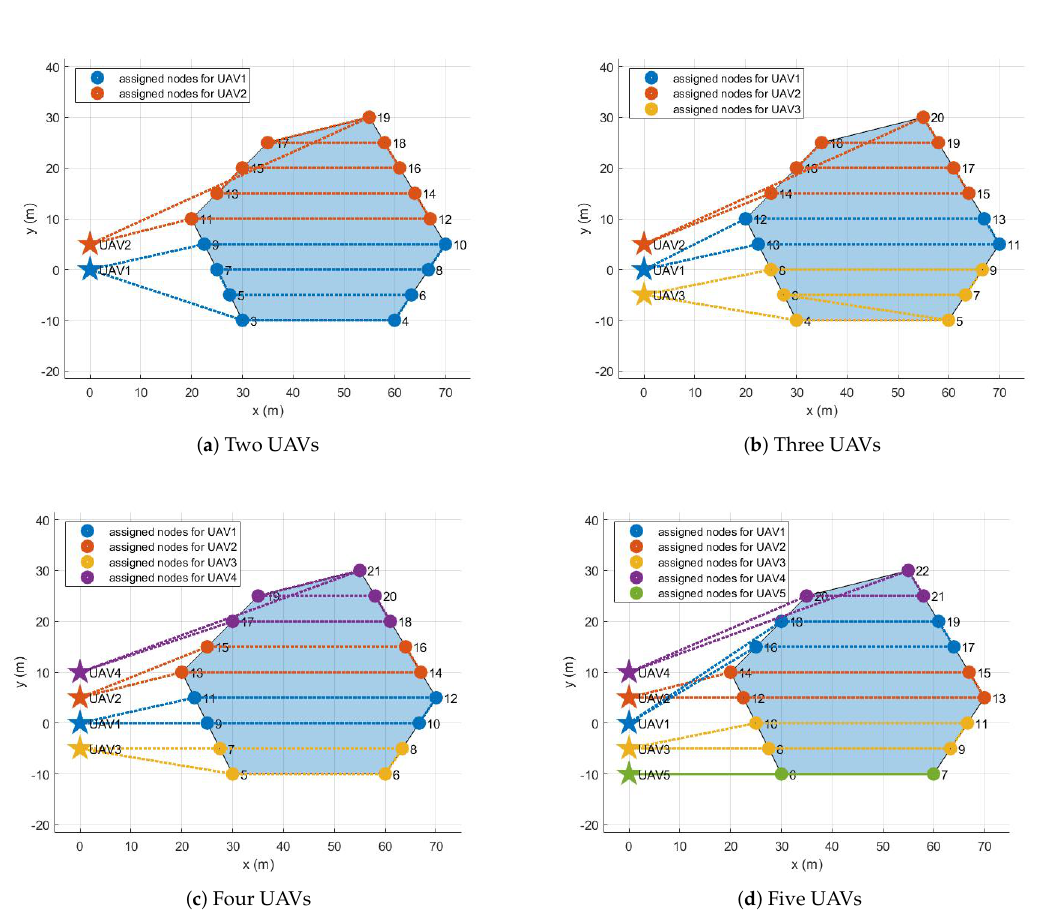
Figure 8. Assignment results for